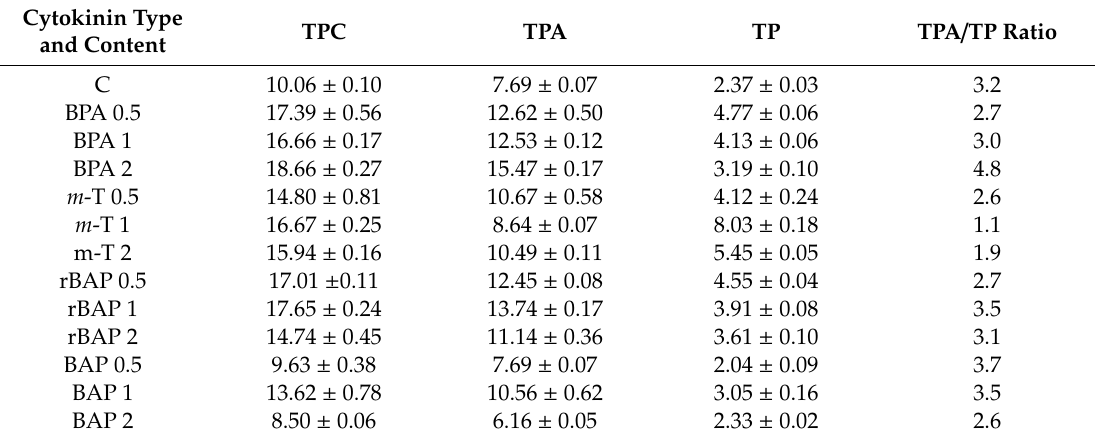
Table 1. Total polyphenol, phenolic acid and phenylethanoid levels in shoot culture of S. viridis . Cytokinin